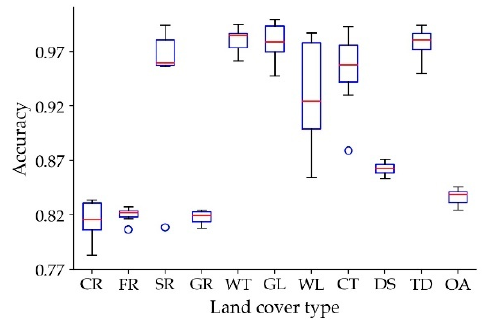
Figure 8. Box diagram of each land cover type and the overall accuracy of the test set in 1980, 1990, 1995, 2000, 2005, 2010 and 2015. Crop (CR), Forest (FR), Shrubs (SR), Grass (GR), Water (WT), Glacier (GL), Wetland (WL), City (CT), Desert (DS), Tundra (TD) and OA(Overall).